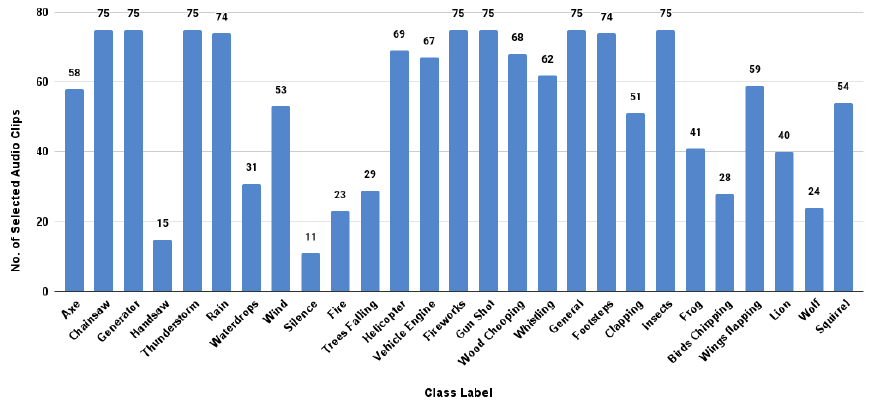
Figure 7. The number of selected audio samples per